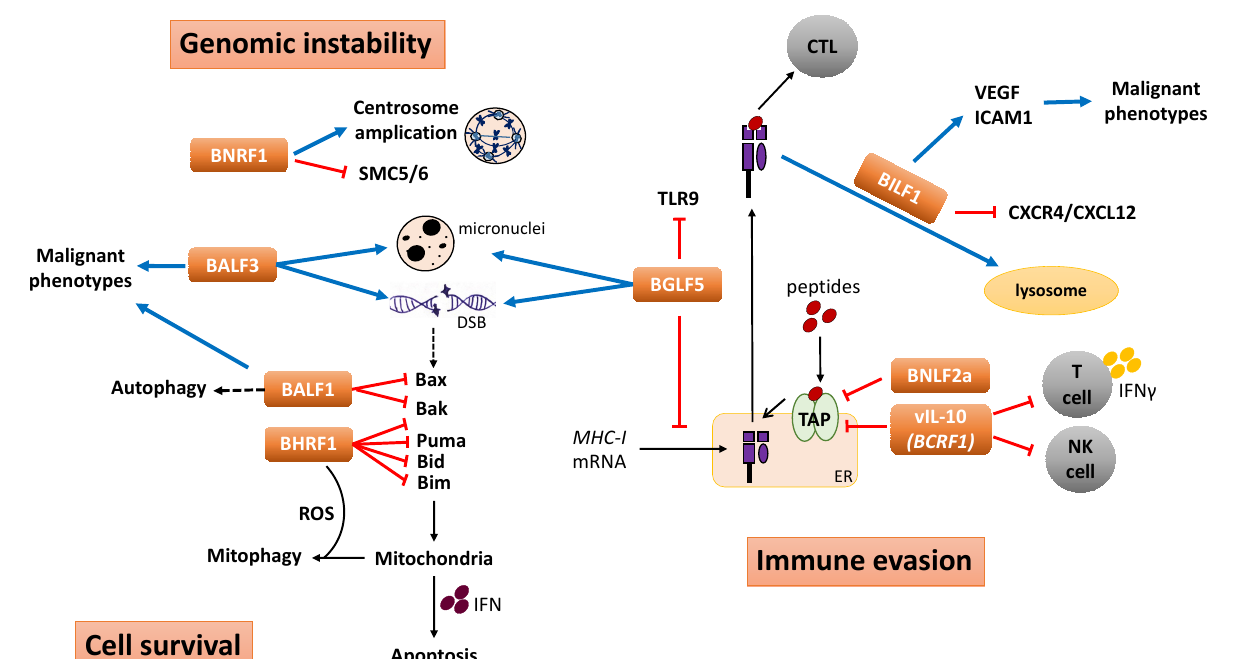
Figure 2. Contribution of EBV lytic gene products to the oncogenic process through immune evasion, induction of genomic instability and enhanced cell survival. BNLF2a, BGLF5, BILF1 and BCRF1 -encoded vIL-10 impair the antigen presentation pathway to evade T cell recognition of EBV-infected cells. vIL-10 also reduces NK cell responses and suppresses T cell activity through inhibition of IFN- γ . Along with BALF3 and BNRF1, BGLF5 also induces genomic instability. BGLF5 and BALF3 induce DNA strand breaks and formation of micronuclei, while BNRF1 causes chromosomal aberrations by inducing centrosome amplification and degradation of SMC5/6 that is crucial in chromosome maintenance and DNA damage repair. In response to apoptosis, BHRF1 and BALF1 protect EBV-infected cells by inhibiting pro-apoptotic Bcl-2 proteins as well as subverting mitochondrial dynamics and regulating autophagy. In addition, BILF1, BALF1 and BALF3 can also promote the malignant phenotype of EBV-positive tumor cells. DSB, double-strand break.